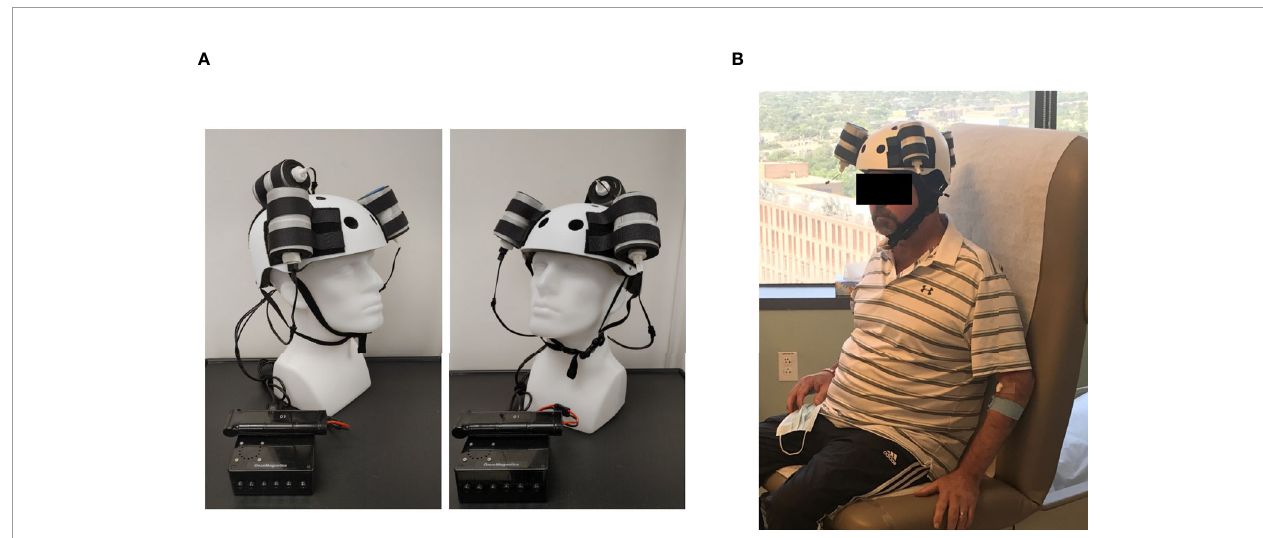
FIGURE 1 | Oncomagnetic Device. (A) Device helmet with 3 oncoscillators securely attached to it. The oncoscillators are connected to a controller box powered by a rechargeable battery. (B) The patient wearing the device helmet with three oncoscillators